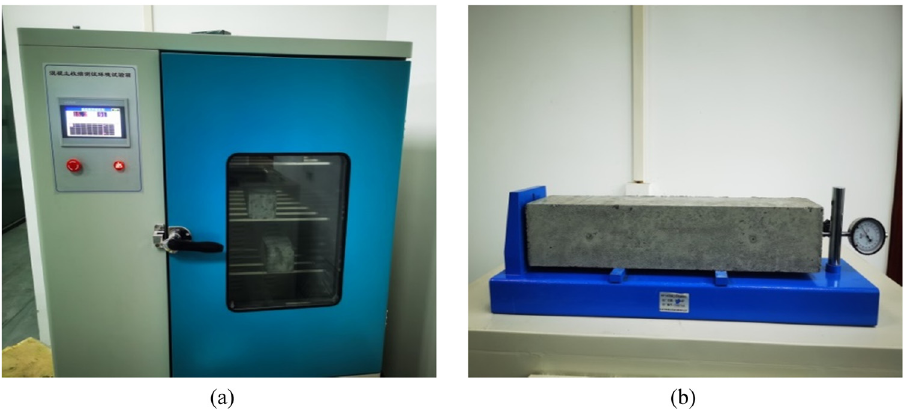
Figure 8: Shrinkage performance of concrete. ( a ) Concrete shrinkage environment test box. ( b ) Horizontal shrinkage apparatus for concrete.